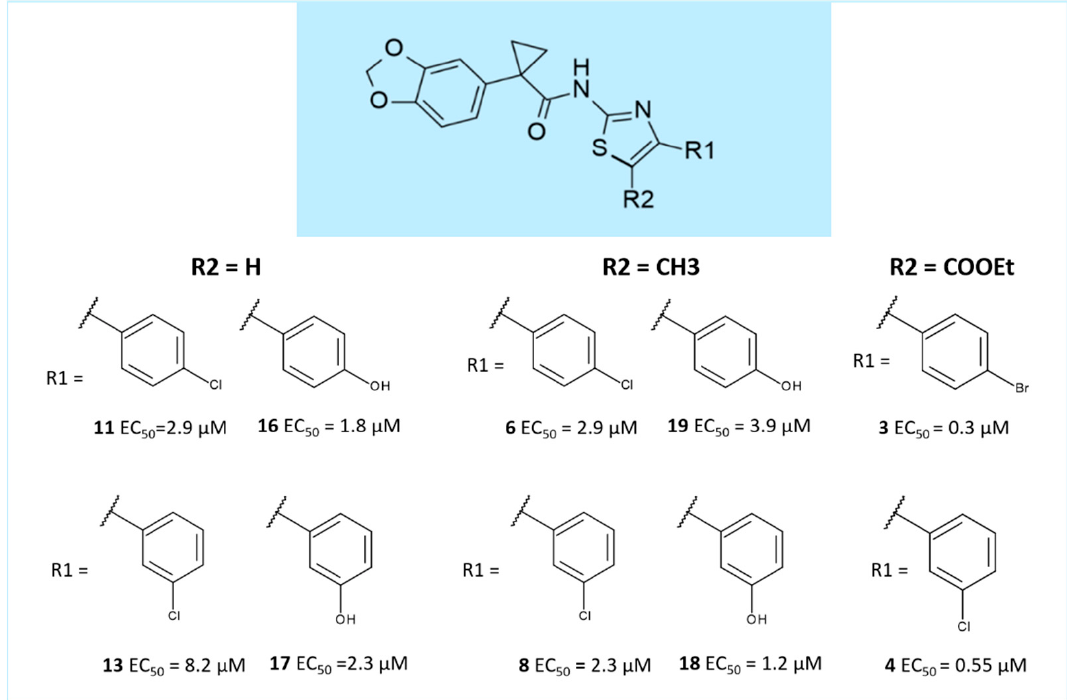
Figure 6. Scheme of the previously disclosed SAR explored for VX-809 and AATs hybrids as F508del-CFTR correctors [30].